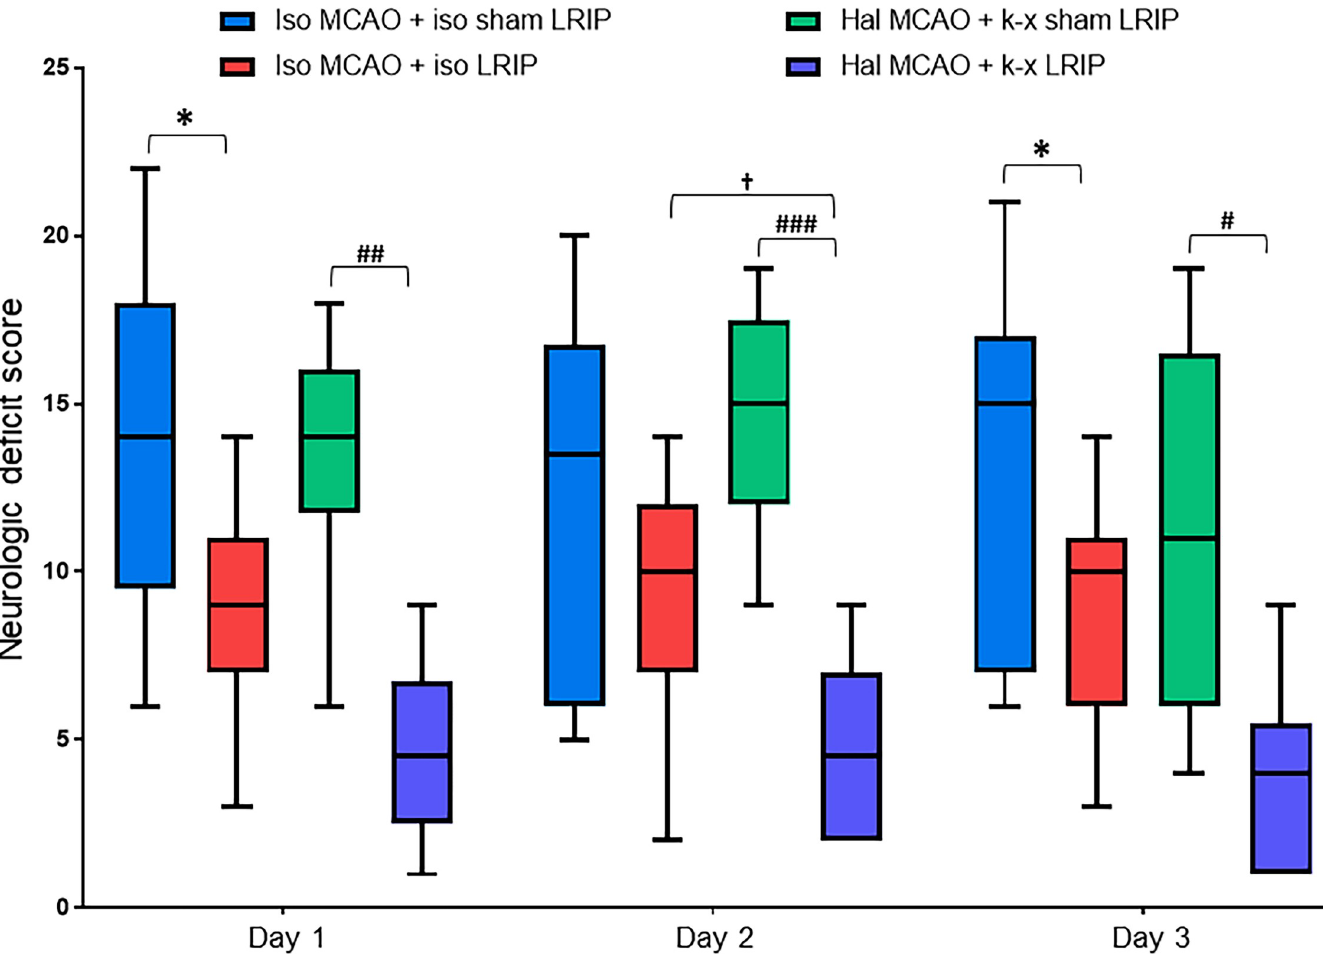
Fig 2. Effects of cerebral ischemia and LRIP on NDS. MCAO significantly augmented the neurologic deficit, which was significantly attenuated by LRIP treatment. Additionally, cohort 4, where ketamine-xylazine was used during LRIP, exhibited a significant difference compared with cohort 2, where isoflurane was used during LRIP. The effects of LRIP on NDS persisted across the time points. Data are presented as mean ± SD. � p < 0.05 when compared cohort 1 vs cohort 2, # p < 0.05, ## p < 0.01, ### p < 0.001 when compared cohort 3 vs cohort 4, and † p < 0.05 when compared cohort 2 vs cohort 4. https://doi.org/10.1371/journal.pone.0227624.g002 PLOS ONE | https://doi.org/10.1371/journal.pone.0227624 January 16,